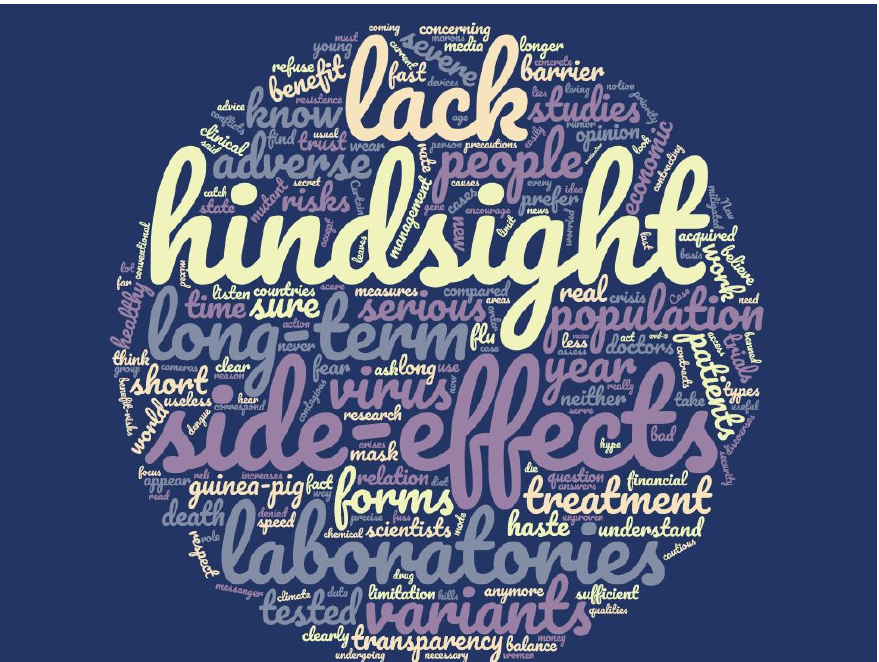
Figure 2. Word cloud from health care workers’ responses to open-ended questions against COVID-19 vaccination.